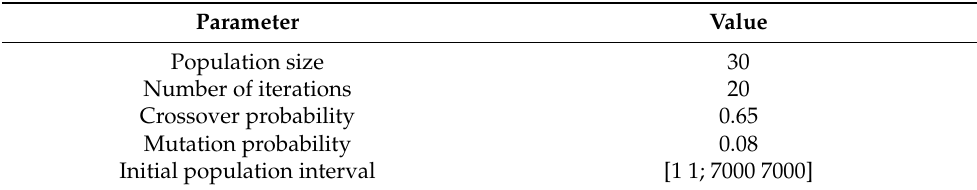
Table 2. Parameters of genetic